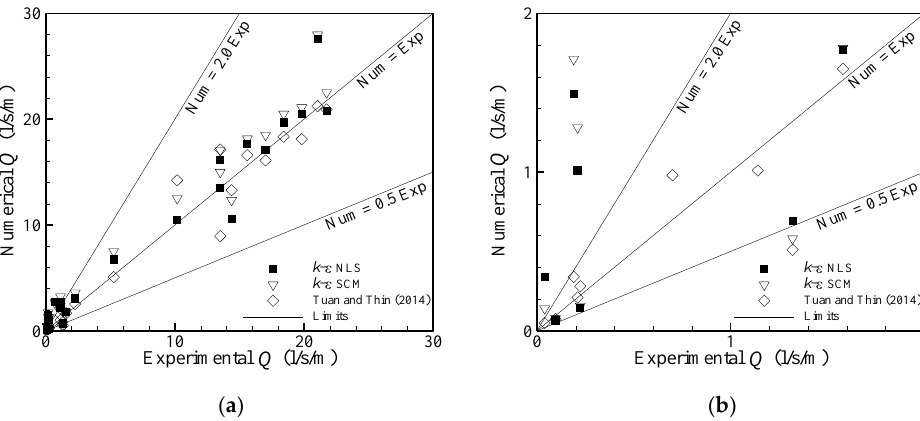
Figure 13. Numerical ( k- ε NLS and k- ε SCM turbulence models and Tuan and Thin [18]) versus experimental (Tuan and Thin [18]) average wave overtopping discharge of regular and random waves: ( a ) all results and ( b ) details for small values of wave overtopping discharge.